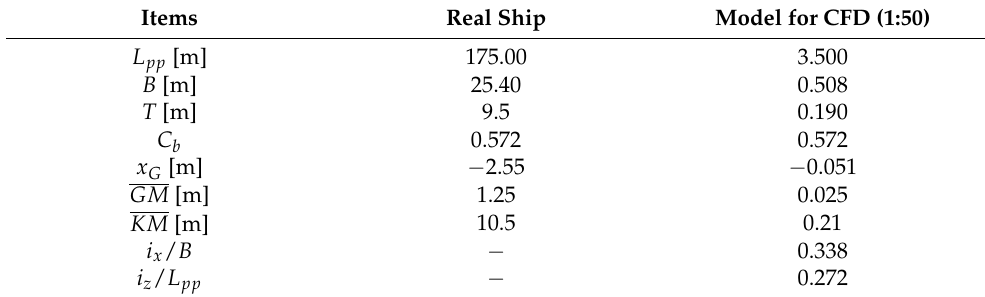
Table 1. Principal dimensions of